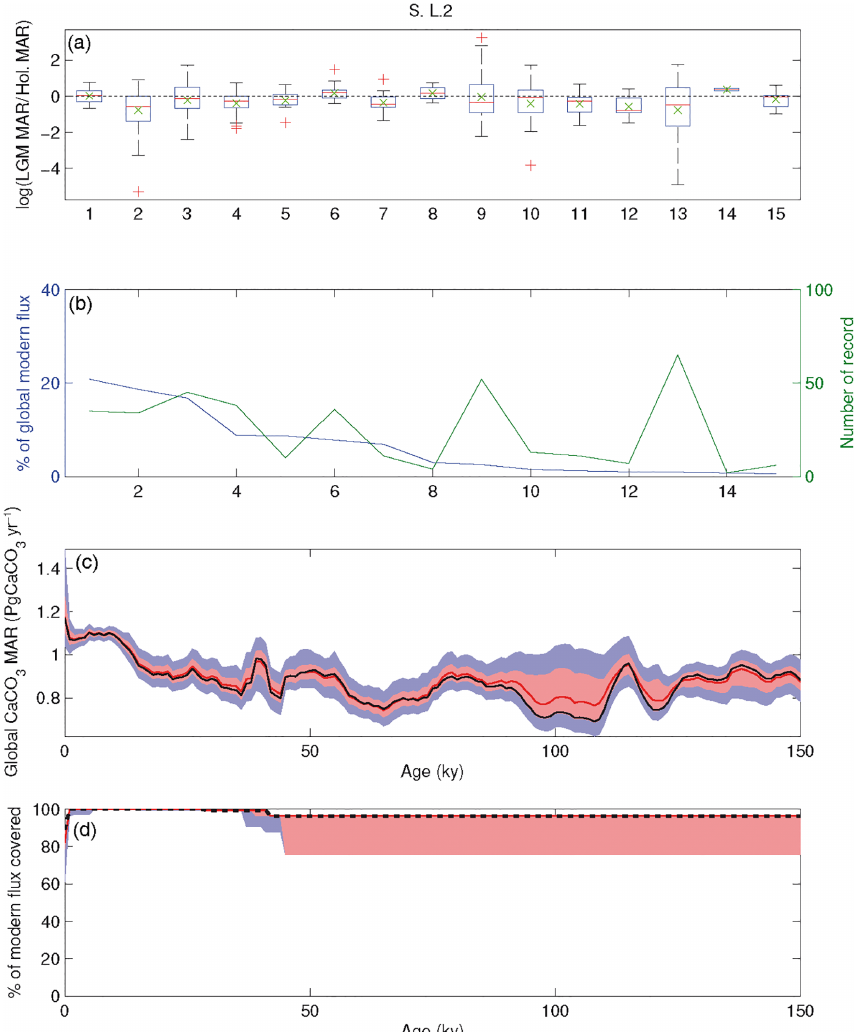
Figure A2. Illustrative summary figure for the province map S.L.2. Panel (a) shows relative changes in downcore CaCO 3 MAR (ln(LGM/Holocene)) in each province. Box plot shows 0% (bottom whiskers), 25%, 50% (median; red lines), 75%, and 100% (top whiskers) quantiles, as well as mean (green cross) and outliers (red cross), for each province. Panel (b) shows the contribution by province to modern CaCO 3 MAR, in descending order (blue curve) and the number of records used in each province (green). Panel (c) shows the history of absolute changes in CaCO 3 MAR for the last 150kyr, based on the bootstrap experiment (5th, 25th, 75th, and 95th percentile ranges are shaded, and the bootstrap mean plotted in red) compared to the calculation using all available records (black). Panel (d) shows the temporal variations in coverage based on the bootstrap experiment. The 5th, 25th, 75th, and 95th percentiles are shaded, and the bootstrap mean is plotted in red. The black dotted line corresponds to the coverage variations using all available